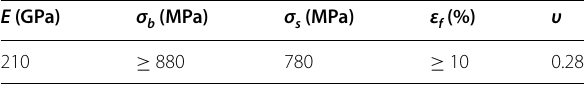
Table 1 Mechanical property parameters of U71MnG rail steel